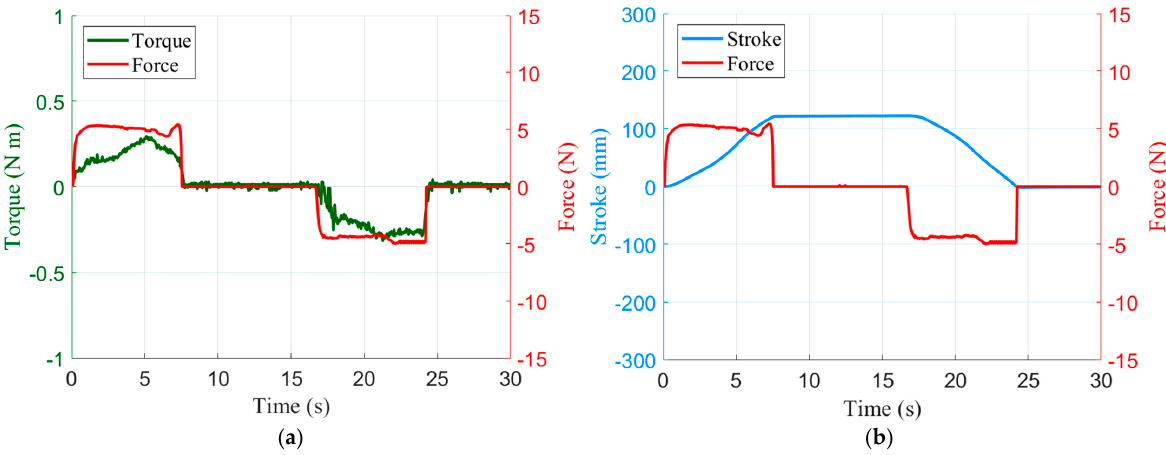
Figure 11. Experimental results of stationary motion: ( a ) estimated torque and force plot; ( b ) stroke and force plot.